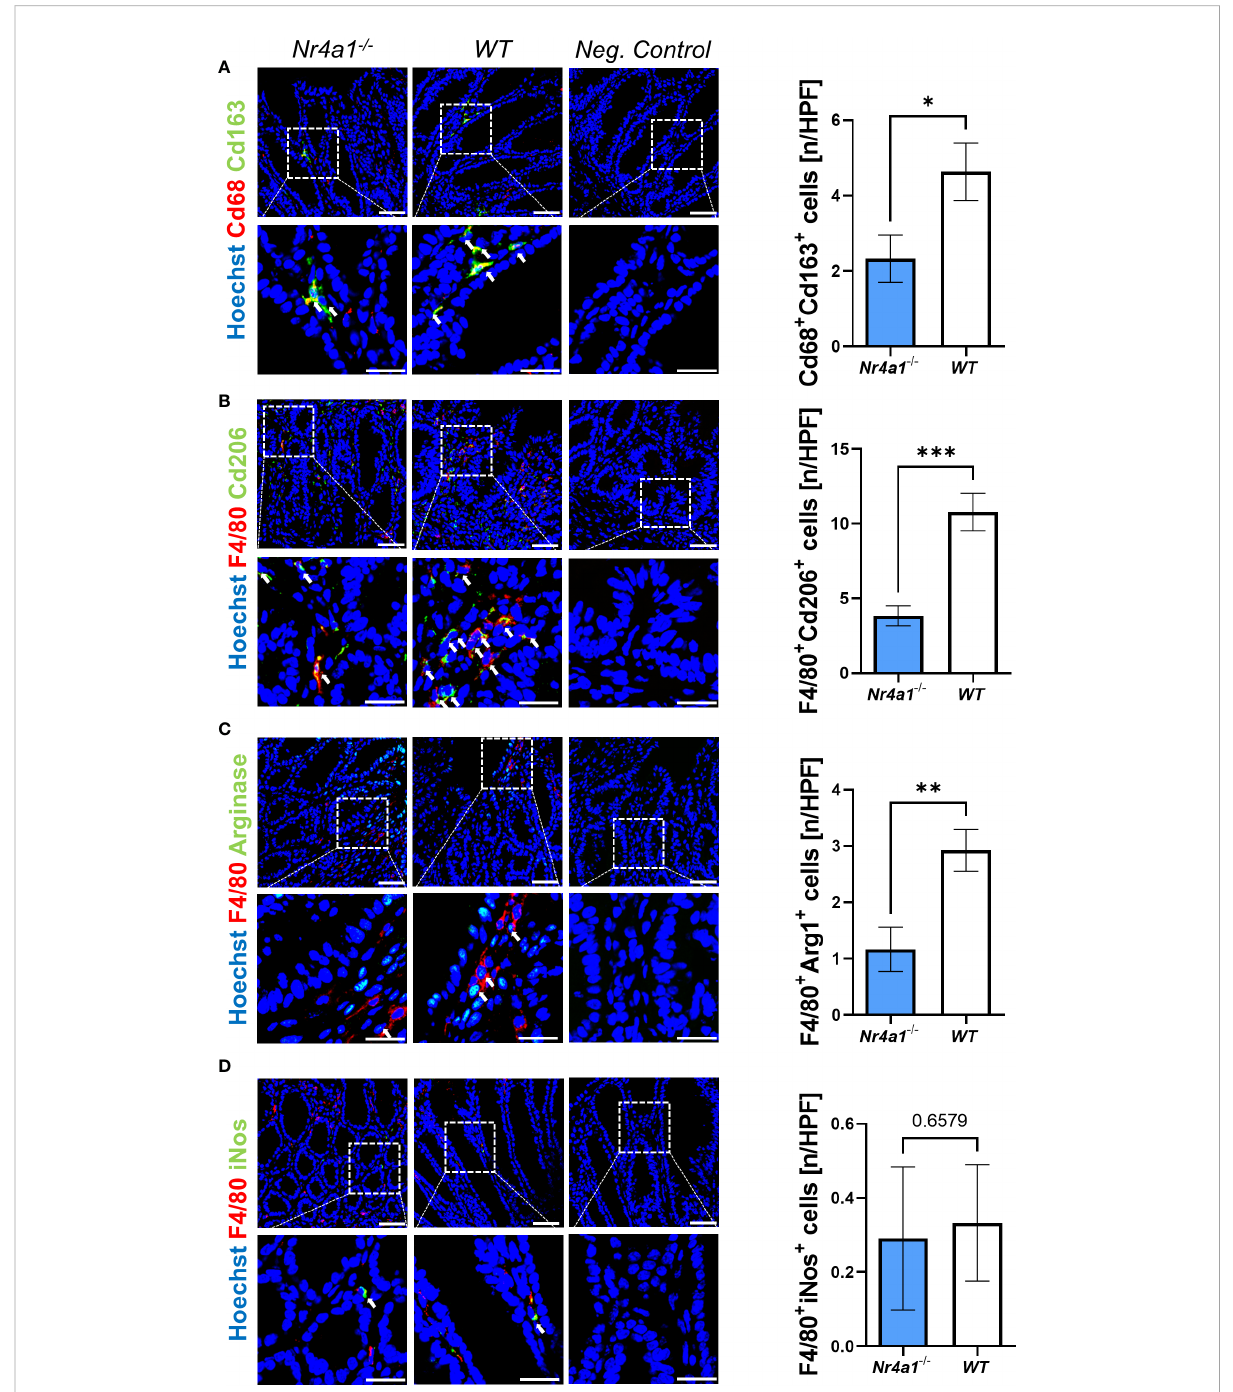
FIGURE 4 Reduced perilesional presence of wound healing macrophages in the colonic mucosa of Nr4a1 -/- mice compared to WT mice. Representative (left) and quantitative immuno fl uorescence (right) for the perilesional co-expression of Cd68 and Cd163 (A) , F4/80 and Cd206 (B) , F4/80 and Arg1 (C) and F4/80 and inducible nitric oxide synthase (iNos) (D) in intestinal wound areas of Nr4a1 -/- mice (n=8) and WT mice (n=9) on day 5 after injury. Scale bars 50 µm (upper panels), 25 µm (lower panels); HPF, high-power fi eld. * p<0.05, ** p<0.01, ***